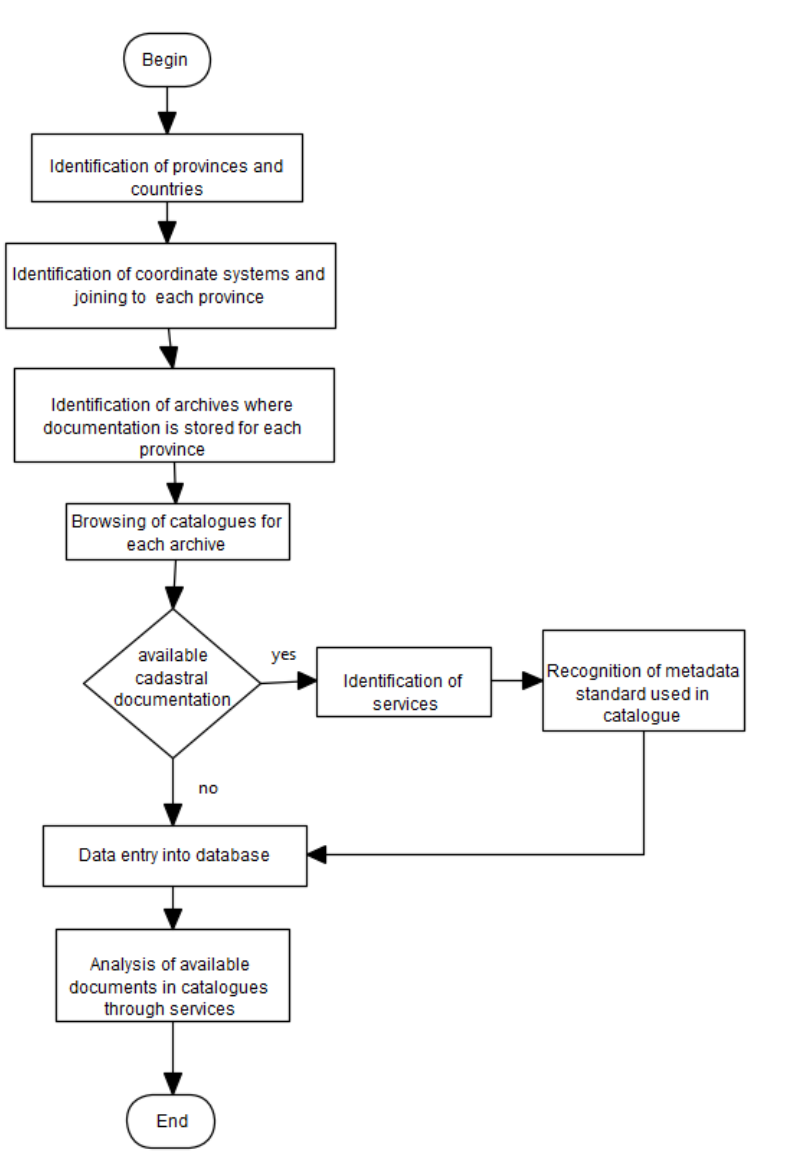
Figure 2. Methodology flow chart of cadastral documentation. Source: Own compilation.